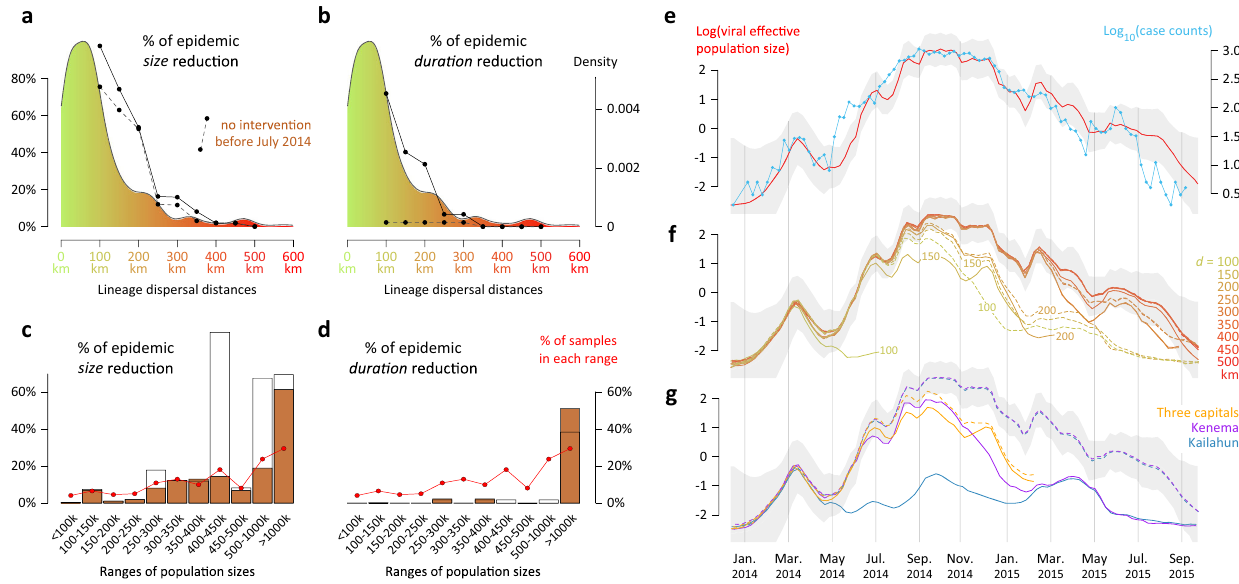
Fig. 1 Hypothetical impact of intervention strategies. a , b Reductions in epidemic size and duration following the prevention of dispersal over a range of distances between administrative areas. These quantities are summarised as the percentages by which phylogenetic tree length and height are reduced when the phylogeny is pruned at all the branches that accommodate such dispersal events (full lines). The dashed lines represent the corresponding reductions when the dispersal events are prevented only after June 2014. These curves are superimposed on the distribution of lineage dispersal distances summarised from the posterior Markov jump history (coloured from green to red). c , d Reductions in epidemic size and duration following the prevention of dispersal to administrative areas belonging to a speci fi c population sizes range. These percentage reductions are also obtained by pruning the phylogeny, but now at all branches that accommodate dispersal events to the relevant administrative areas (white histogram bars). The brown histogram bars represent the corresponding reductions when the dispersal events are prevented only after June 2014. We refer to Supplementary Fig. 1 for credible intervals associated with percentages of epidemic size/duration reductions reported in Fig. 1a – d. All the reductions in tree length and height were computed by conditioning the pruning on movement events recorded in the MCC (maximum clade credibility) tree summary of the discrete phylogeographic reconstruction. Supplementary Fig. 2 summarises the equivalent results for pruning trees using the Markov jump histories associated with each posterior tree. e Estimates of viral population size (in red; 95% HPD in grey) and the time series of case counts (in blue). f Impact of preventing long- distance dispersal events on viral effective population size through time. As in Fig. 1e, the 95% HPD of viral population size based on the entire dataset (no intervention strategy) is displayed in grey. On this graph, dashed lines correspond to viral population size evolution when transmission is prevented only after June 2014. g This plot corresponds to Fig. 1f but focuses on the impact of preventing dispersal events to speci fi c locations on viral effective